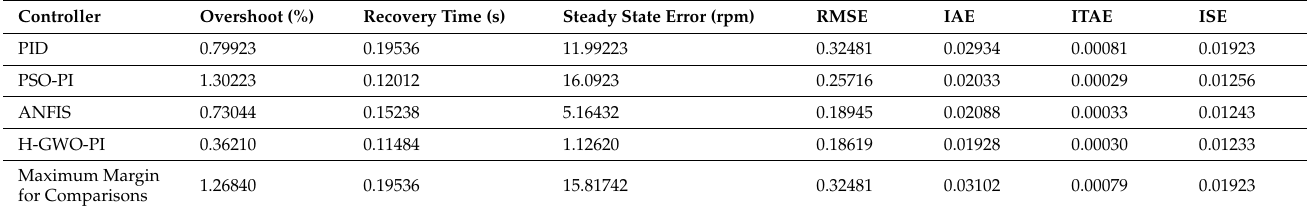
Figure 12. Response of the Brushless DC motor in terms of speed under Case B. Table 4. Performance parameters for Case B condition.